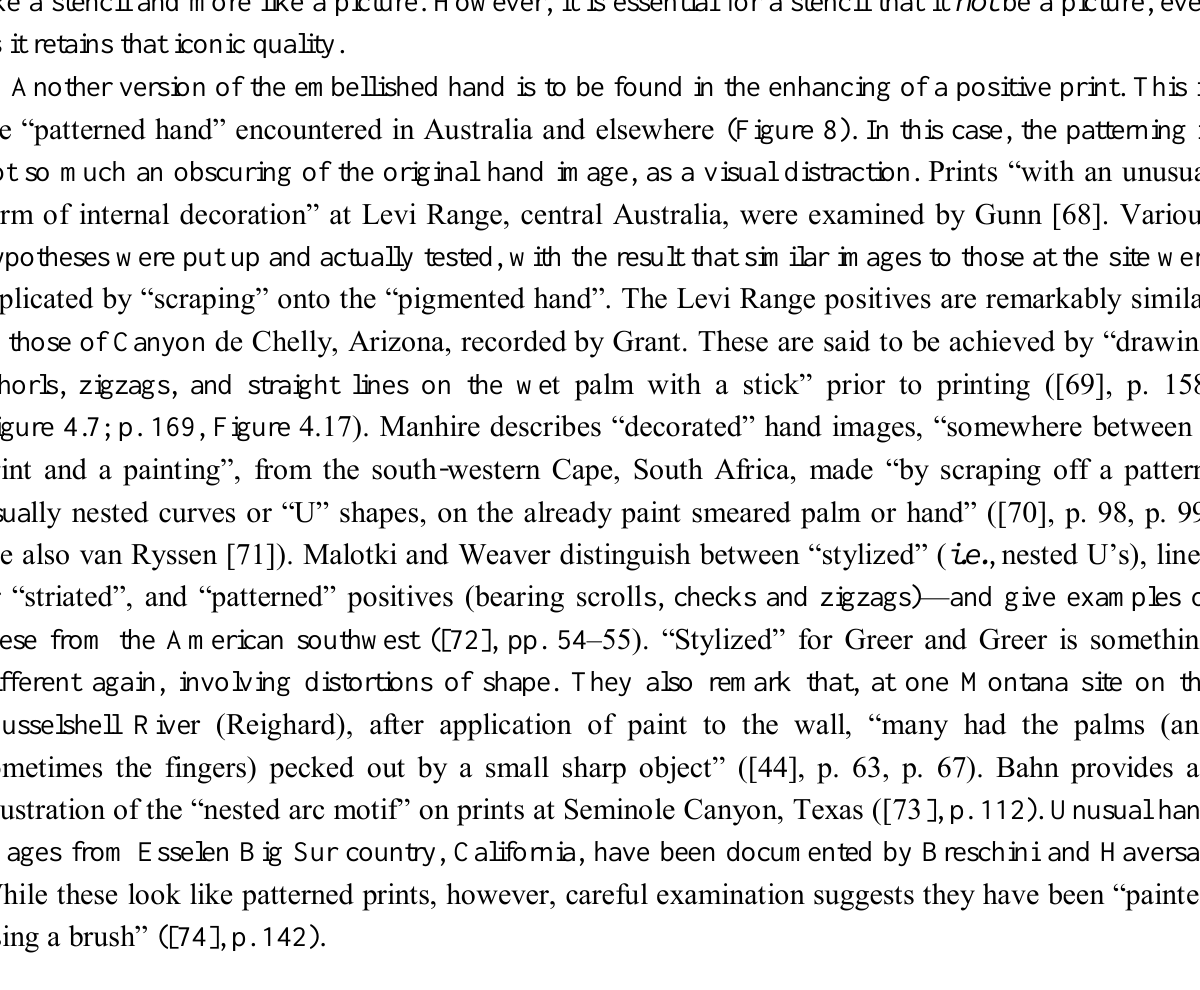
Figure 8. “Patterned hands”, central Australia. Courtesy R.G. (“ben”)